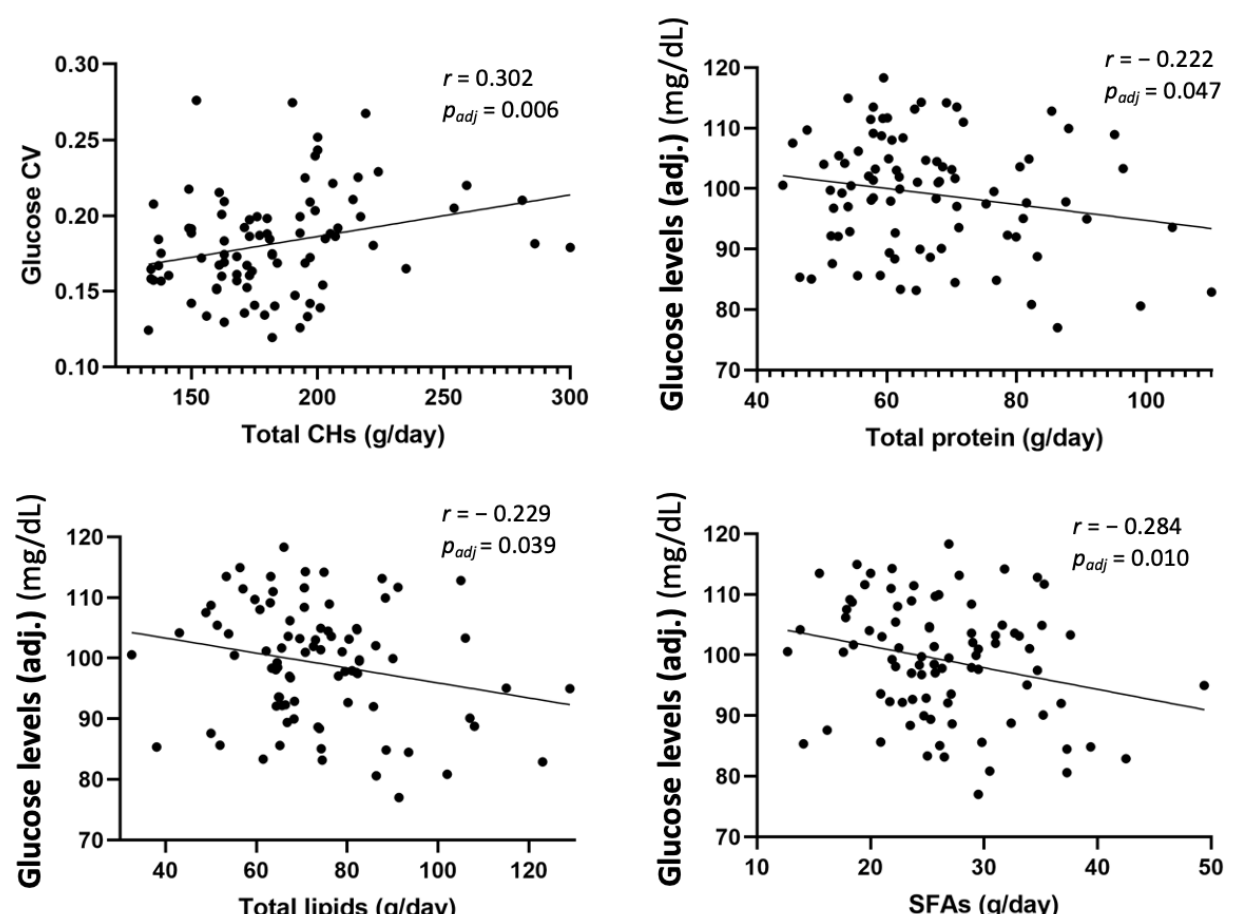
Figure 6. Partial correlation to evaluate potential associations between glucose data and dietary intake in children at 6 years, adjusted by study group, maternal age, parents’ educational level, and socioeconomic status. Glucose CV does not have any measurement units. Adj: adjusted mean glucose levels; CHs: carbohydrates; CV: glucose coefficient of variation; SFAs: saturated fatty